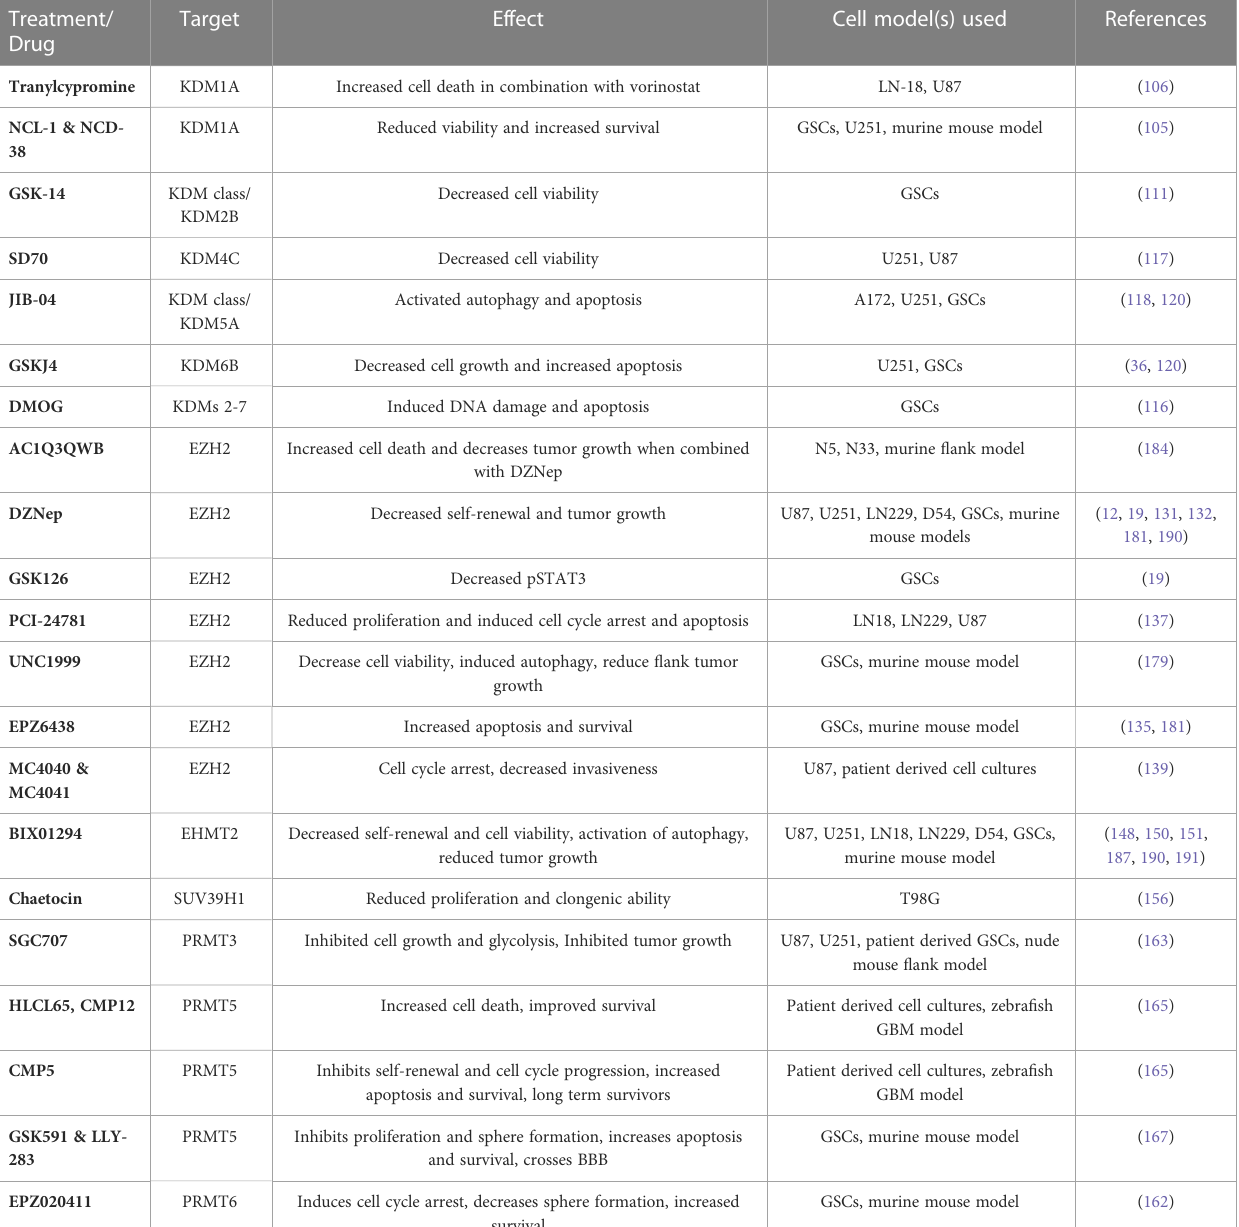
TABLE 5 The effect of select histone methyltransferase and histone demethylase inhibitors in GBM pathophysiology. Treatment/